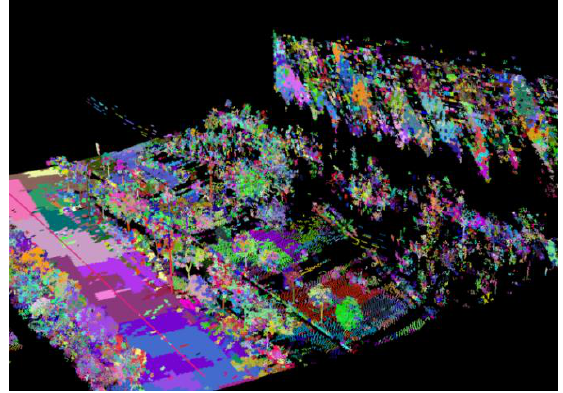
Figure 4. Group into segments